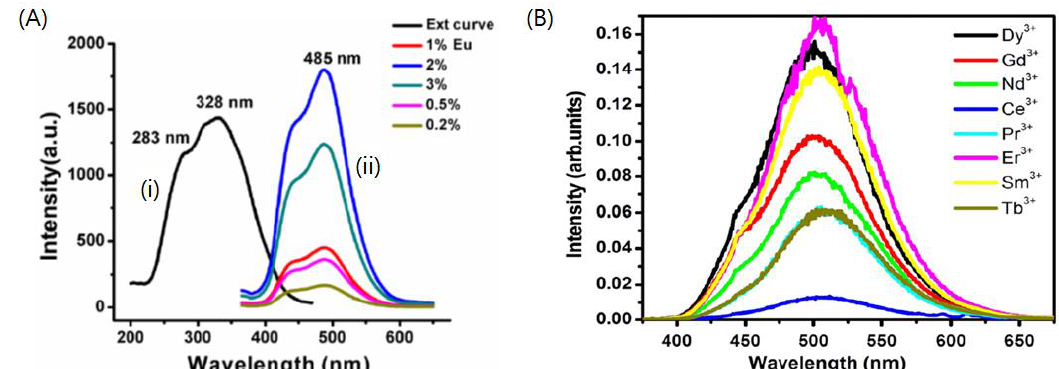
Figure 4. Photoluminescence spectra for lanthanide doped barium aluminate phosphors ( A ) Photoluminescence excitation (i) and emission (ii) spectra for BaAl 2 O 4 :Eu 2+ . Adapted from [30] under Creative Commons Attribution (CC BY) license. ( B ) Photoluminescence emission spectra of BaAl 2 O 4 :Eu 2+ , Re 3+ (Re = Dy 3+ , Er 3+ , Sm 3+ , Gd 3+ , Ce 3+ , Pr 3+ and Nd 3+ ). Adapted with permissions from [95] . Copyright Elsevier, 2012.